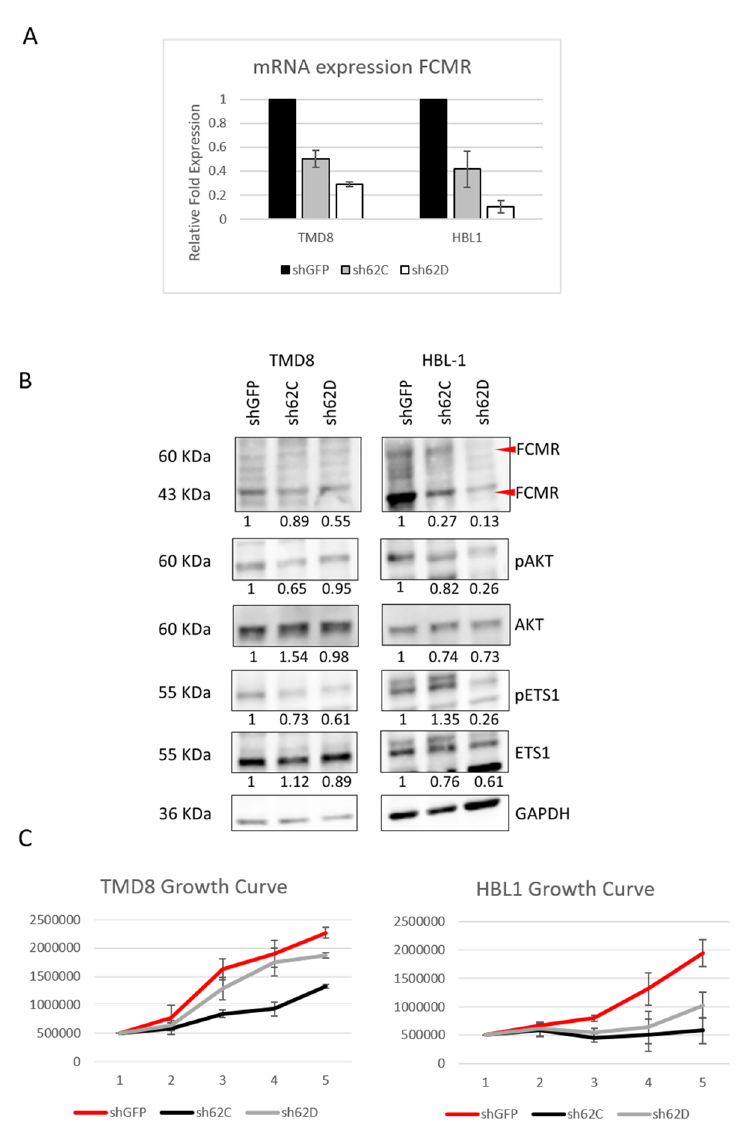
Figure 5. Functional analysis of FCMR knockdown in TMD8 and HBL1. ( A ) Normalized (to GAPDH) relative mRNA expression of FCMR in in TMD8 and HBL1 after knockdown using a pLKO.1 lentiviral vector expressing shRNA targeting FCMR (sh62C or sh62D) and a non-expressed gene target shGFP. ( B ) Protein expression of FCMR, ETS1, and AKT as well as phosphorylation status in TMD8 and HBL1 cell lines after FCMR knockdown. Ratios below bands are relative to control and normalized to GAPDH. ( C ) Growth of TMD8 and HBL1 over the course of five days of cell culture. Each data point represents an average of three technical replicates. Uncropped blots see Figure S10.